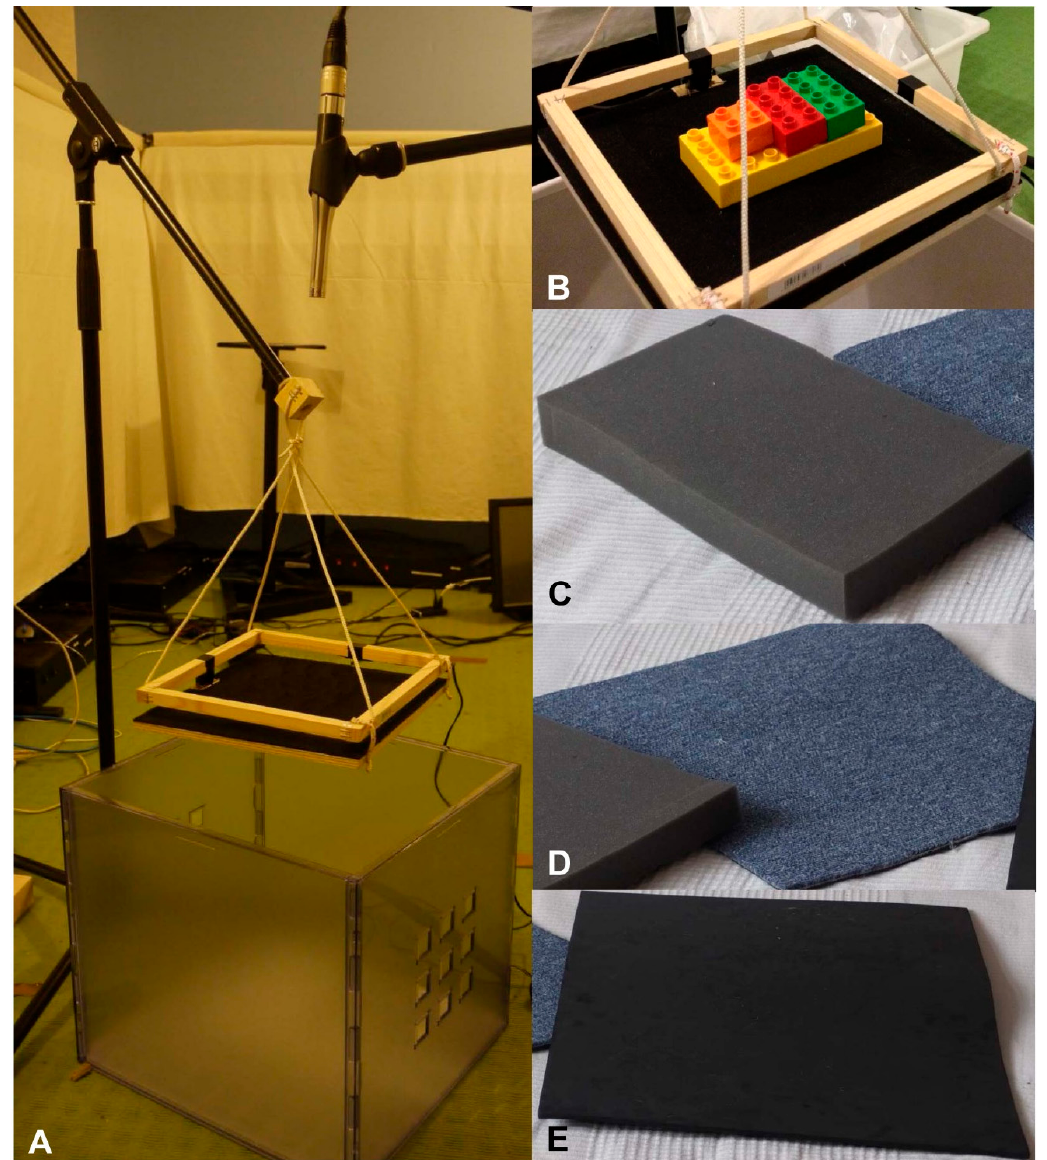
Figure 1. Experimental setup and damping materials: ( A ) self-constructed setup; ( B ) arrangement of selected DUPLO bricks; ( C ) PU foam; ( D ) carpet; and ( E ) foam rubber.